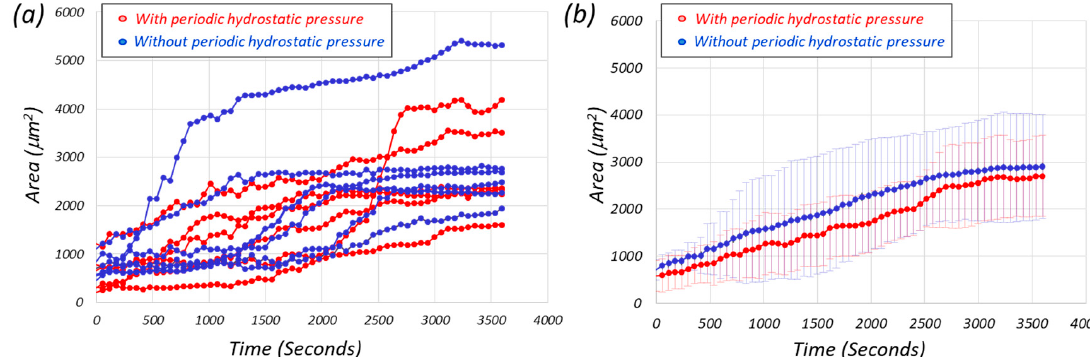
Figure 5. The growth of the projected area with respect to time, where the cell groups with and without periodic hydrostatic pressure are indicated by red and blue marks, respectively. ( a ) Measured area of six cells from the periodic hydrostatic pressure chamber (red) and 6 cells from control (blue), a culture chamber without periodic hydrostatic pressure ( b ) The average value and standard deviation from the six cells in each chamber are plotted. No significant difference between two.